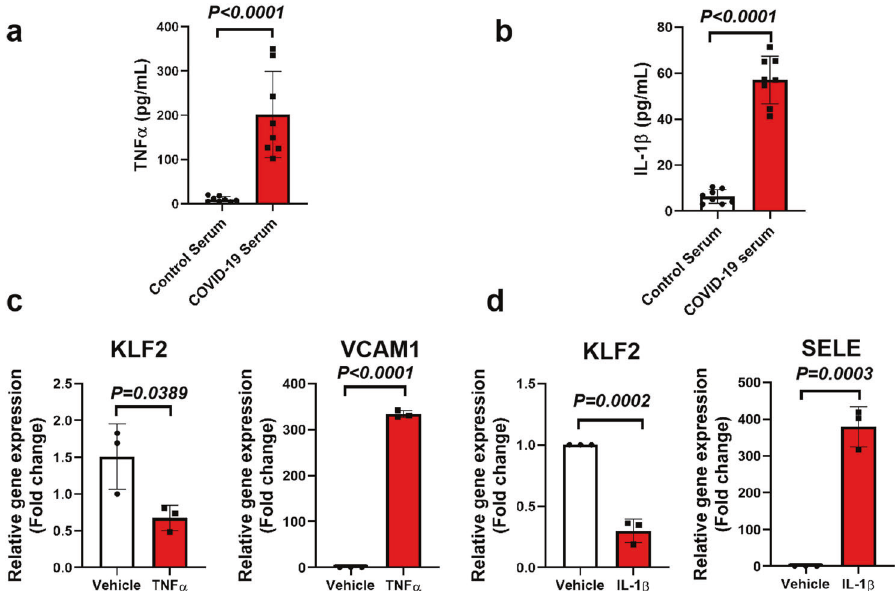
Fig. 2 KLF2 is downregulated by components of cytokine storm- TNF- α and IL-1 β . a , b Circulating levels of TNF- α and IL-1 β were determined by ELISA. N = 8. c HUVECs were treated with vehicle (PBS) or TNF- α (10 ng/ml in PBS) for 6 h before RNA was collected for real-time PCR analysis of KLF2 gene expression using VCAM1 gene as the positive control. N = 3. d HUVECs were treated with vehicle (PBS) or IL-1 β (10 ng/ml in PBS) for 6 h before RNA was collected for real-time PCR analysis of KLF2 gene expression using E-selectin (SELE) gene as the positive control. N =